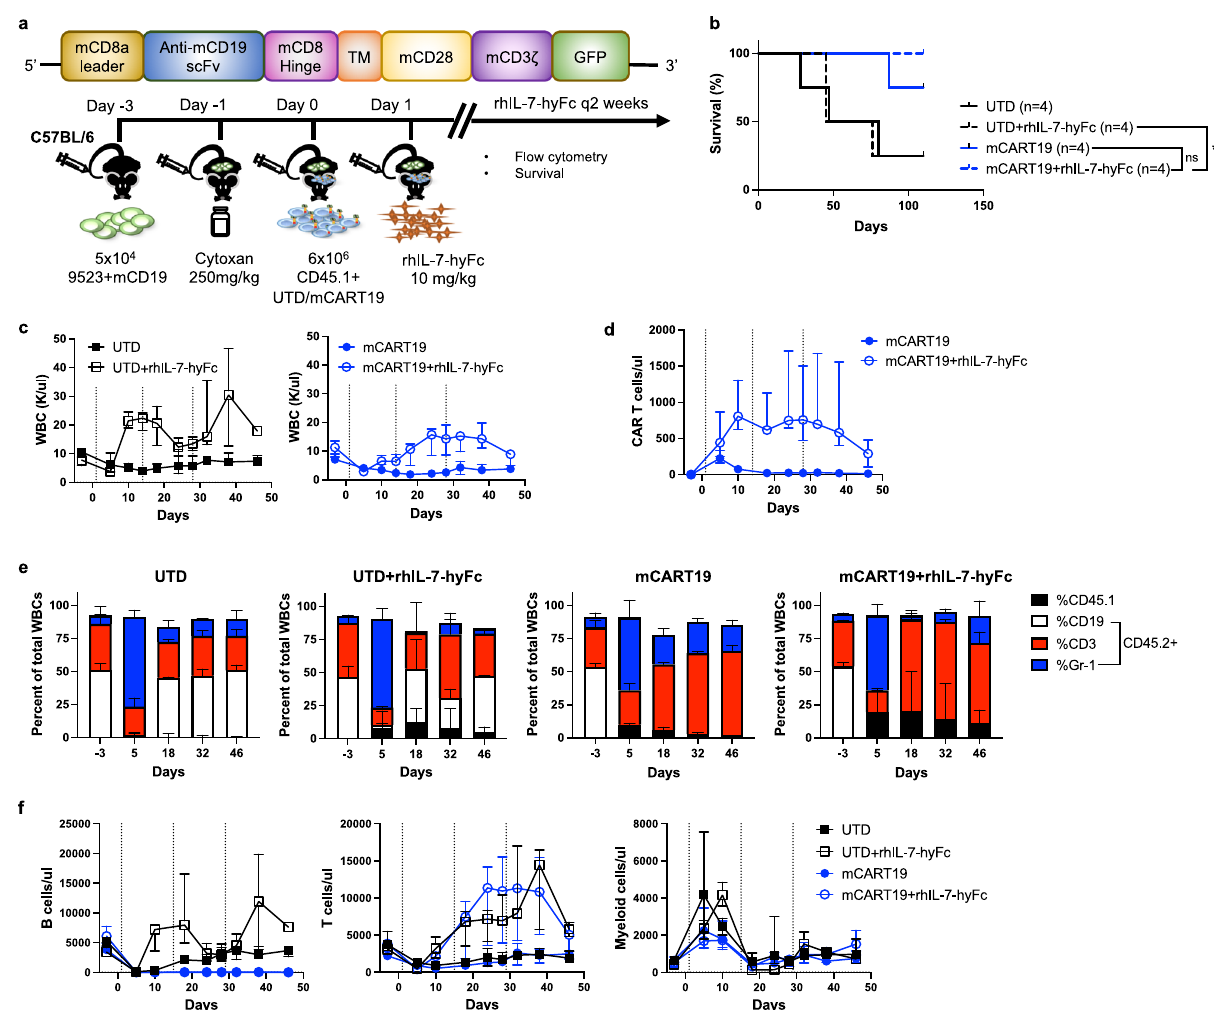
Fig. 4 rhIL-7-hyFc enhances mCART19 expansion and persistence in immunocompetent mice. a C57BL/6J mice were injected with 5 × 10 4 syngeneic tumor cells (9523, a myeloid cell line to which murine CD19 expression was added) followed by cyclophosphamide (Cytoxan) conditioning one day prior to receiving 6 × 10 6 UTD or murine CART19 (mCART19), then given serial injections of rhIL-7-hyFc on days + 1, + 15, and + 29 ( n = 4/group). b Overall survival of mice in each group. p Values were calculated using two-sided Wilcoxon test (mCART19 + rhIL-7-hyFc vs. mCART19, p = 0.32, mCART19 + rhIL- 7-hyFc vs. UTD + rhIL-7-hyFc, p = 0.044). c Peripheral blood total WBC counts over time. d Absolute numbers of mCART19 cells over time. e Total WBC counts were fractionated by fl ow cytometry into percent CD45.1 + (adoptively transferred T cells) and CD45.2 + (endogenous cells); CD45.2 cells are subdivided into CD19 + B cells, CD3 + T cells, and Gr-1 + myeloid cells at the indicated timepoints. f Absolute numbers of CD45.2 + B cells, T cells, and myeloid cells over time, calculated by multiplying the total WBC count by the fraction of each cell determined by fl ow cytometry. All data represent median± range. Dotted lines represent rhIL-7-hyFc injection time points. Source data are provided as a Source data fi le. ns: not signi fi cant, * p ≤